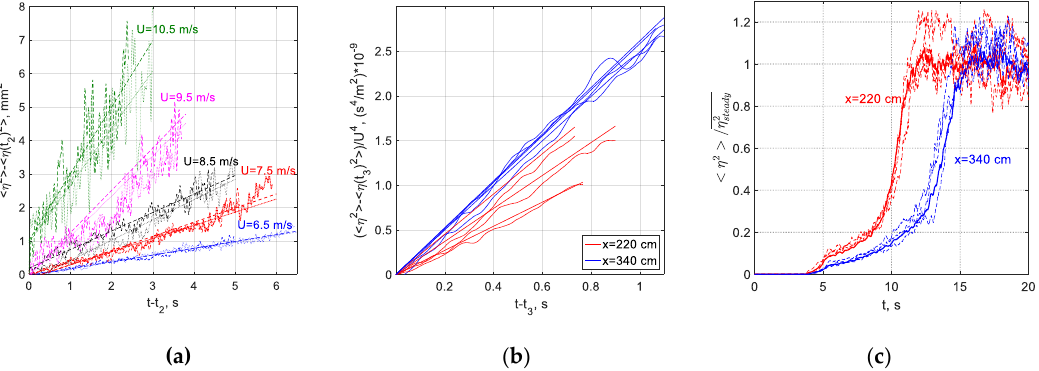
Figure 28. ( a ) Initial stage that occurs during t 2 < t < t 3 , dashed lines for x = 220 cm; dotted lines for x = 220 cm, straight lines: linear fit; ( b ) normalized by U 4 wave energy variation during the “principal development stage” according to Phillips, t 3 < t < t 4 . Straight lines denote linear fit. ( c ) The growth of wave energy with time at two fetches, normalized by steady-state values. The solid lines denote the averaging over different wind velocities; broken lines represent the three highest wind velocities.